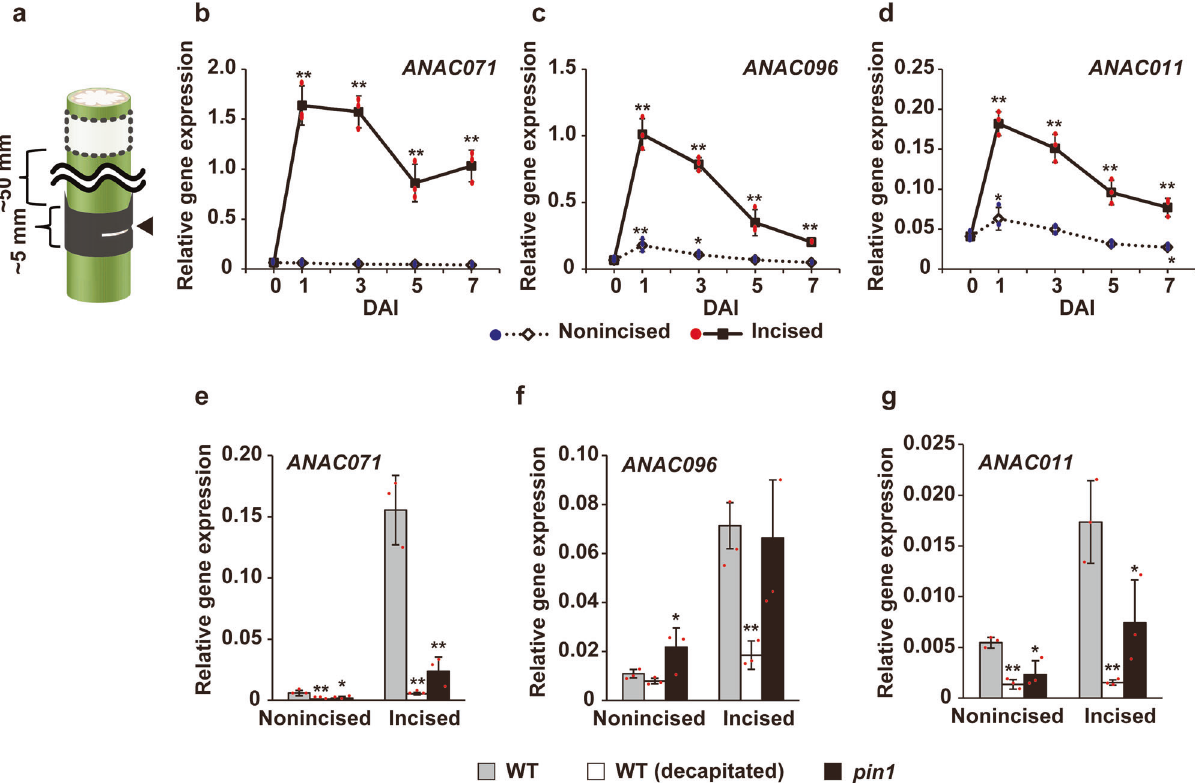
Fig. 2 ANAC gene expression at 1 to 7 days after incision. a Schematic model of the sampling region from the incised stem for qRT-PCR analysis of b – d . Stem samples (~5 mm length) were separately harvested from the region including the incision (black) and from the nonincised region located ~50 mm above the incision (white). Arrowheads indicate the incision. b – d Relative gene expression of ANAC071 , ANAC096 , and ANAC011 was analyzed in fl owering stems at 1 – 7 days after incision (DAI). e – g The relative expression levels of ANAC071 , ANAC096 , and ANAC011 were analyzed in fl owering stems at 3 DAI. pin1 mutants were con fi rmed by T-DNA insertion with PCR and by the phenotype of the pin-formed fl owering stem. Values are normalized by ACT2 expression and represent the means of triplicate experiments ± SD. Sampling time at 0 DAI means stem before incision (harvested from same height as incised region; black box in a ). Asterisks indicate statistically signi fi cant differences compared with 0 DAI or WT (* P < 0.05, ** P < 0.01; Dunnett ’ s